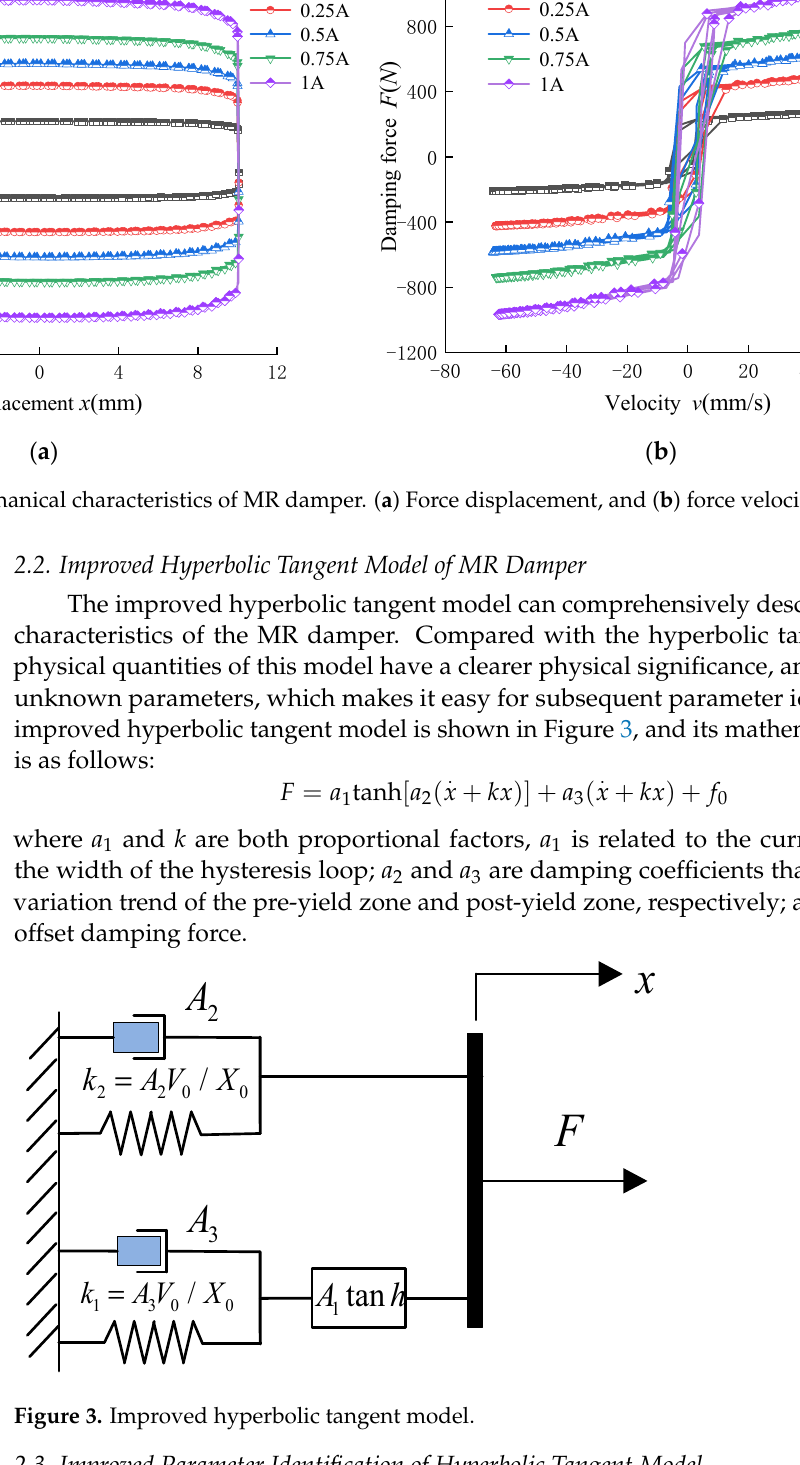
Figure 2. Mechanical characteristics of MR damper. ( a ) Force displacement, and ( b ) force velocity.